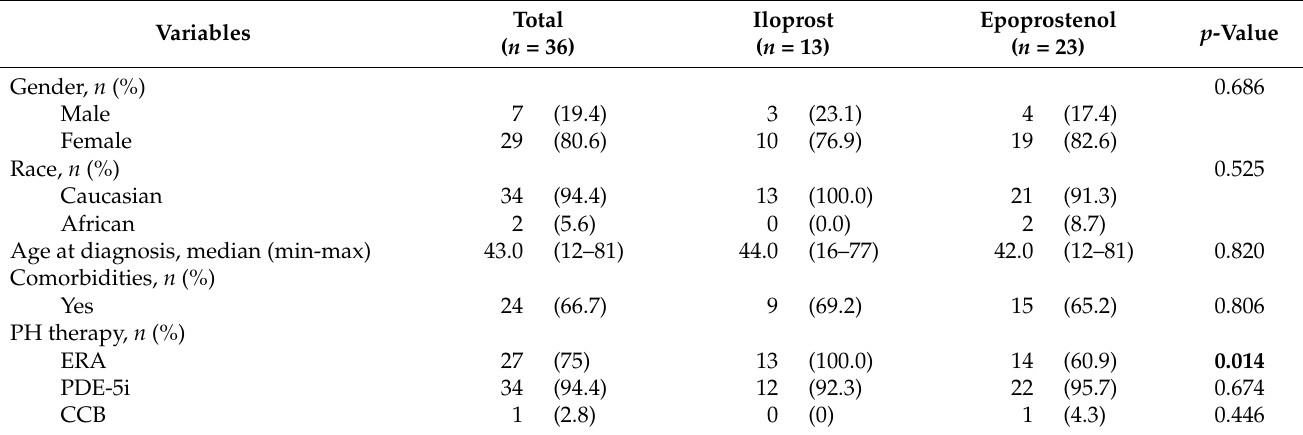
Table 1. Patient characteristics.